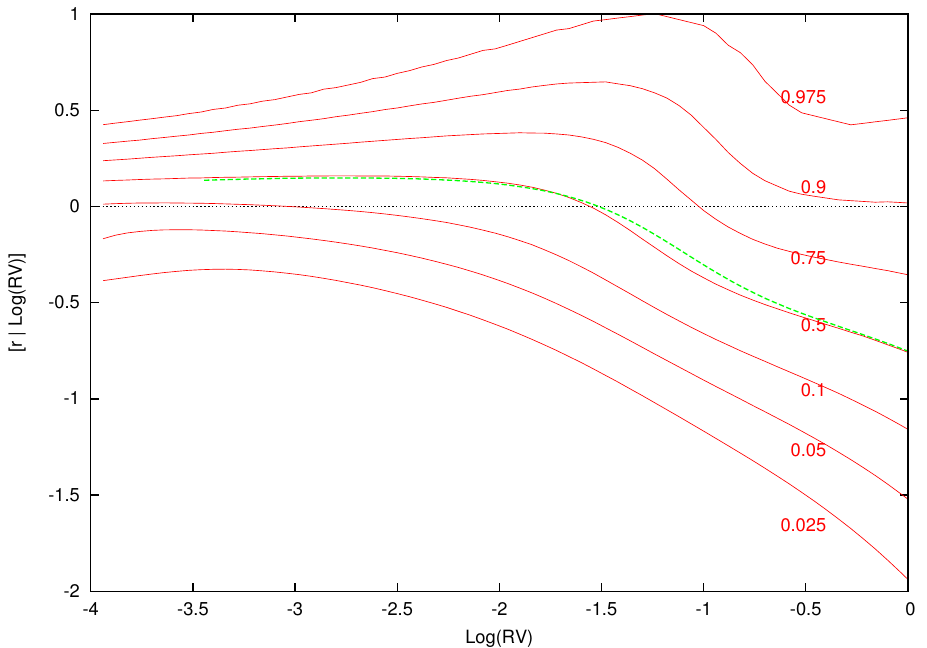
Figure 12. Quantiles of excess returns given log ( RV ) for average volatility. This figure displays the quantiles of the distribution of excess returns conditional on log ( RV ) for I t − 1 , t = 1996 : 2. The green dotted line is the expected excess return given log ( RV )